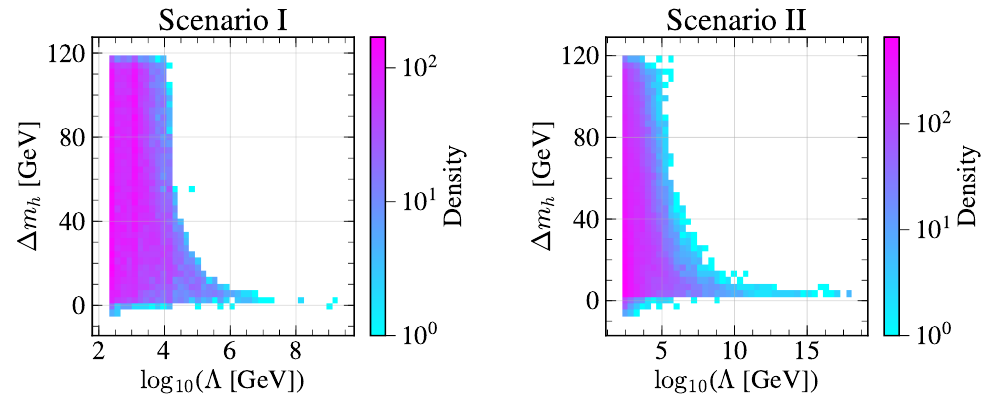
Figure 4 . The density of parameter points per bin as a function of (cid:1) m h and the RG breakdown energy (cid:3); where (cid:1) m h is de(cid:12)ned as the di(cid:11)erence between the 1-loop corrected and the